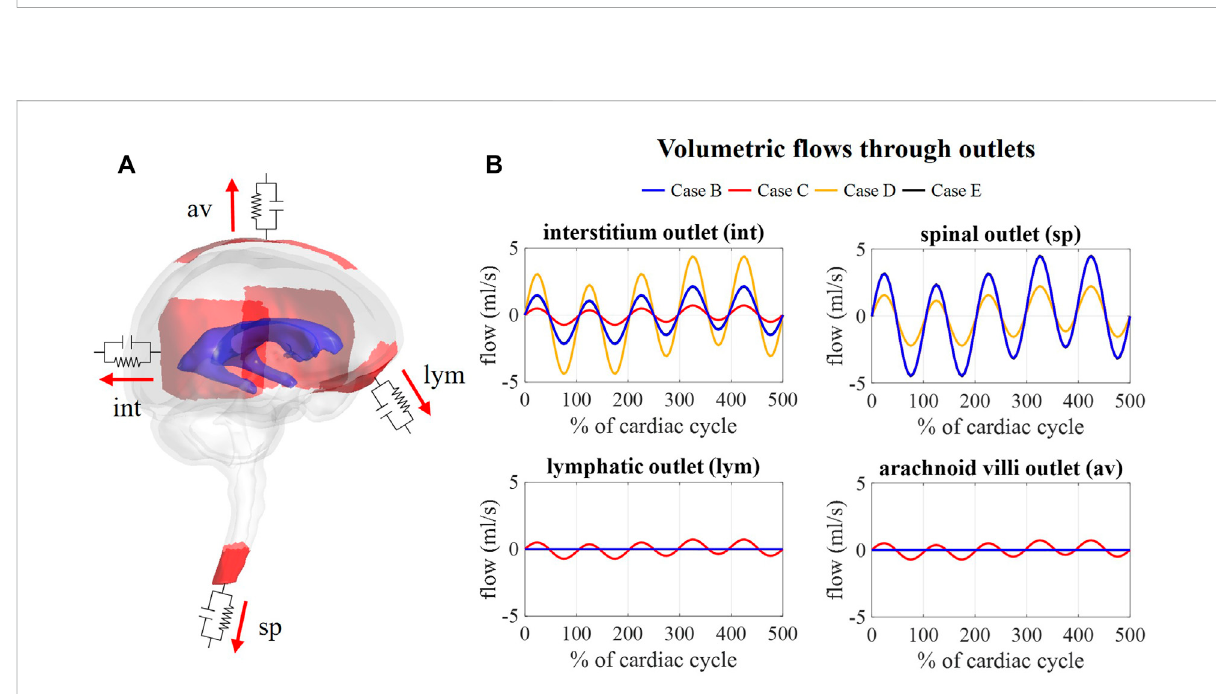
FIGURE 9 Flowobtainedateachoutletfordifferentvaluesofcompliancecorresponding. (A) Visualizationofoutletswithwindkesselboundaryconditions. (B) Graphs showing the fl ow through the interstitium, spinal, lymphatic, and arachnoid villi outlet for case B, C, D, and